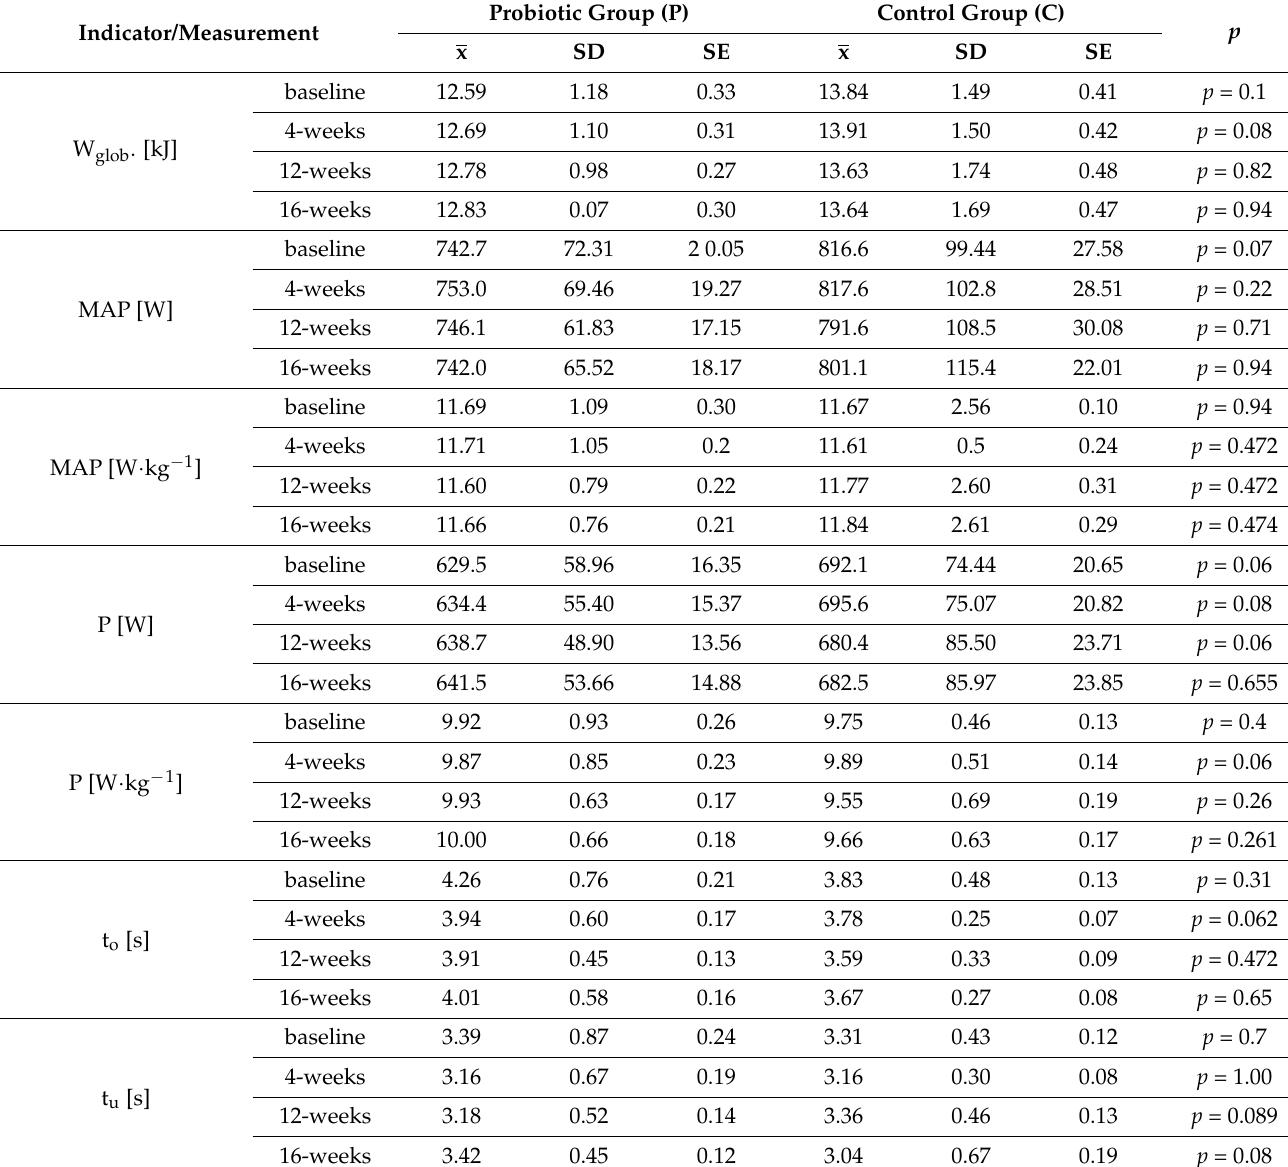
Table 4. Global workload W glob . [kJ], level of maximal anaerobic power MAP [W],